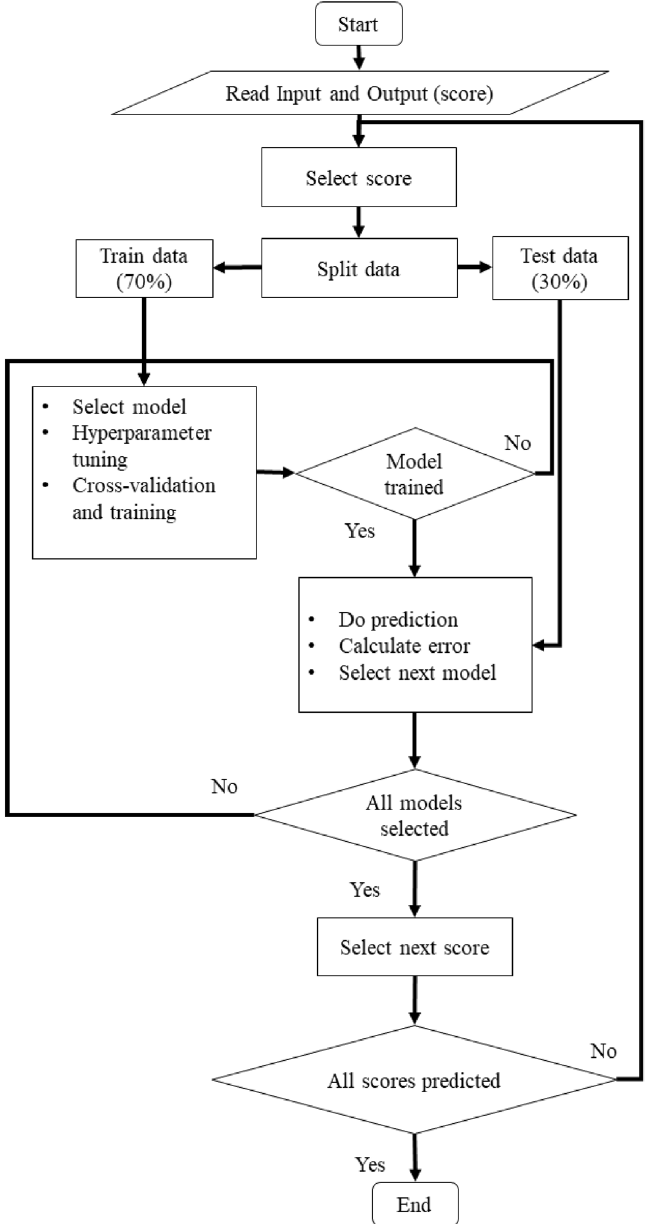
Figure 2. Flow chart of machine learning